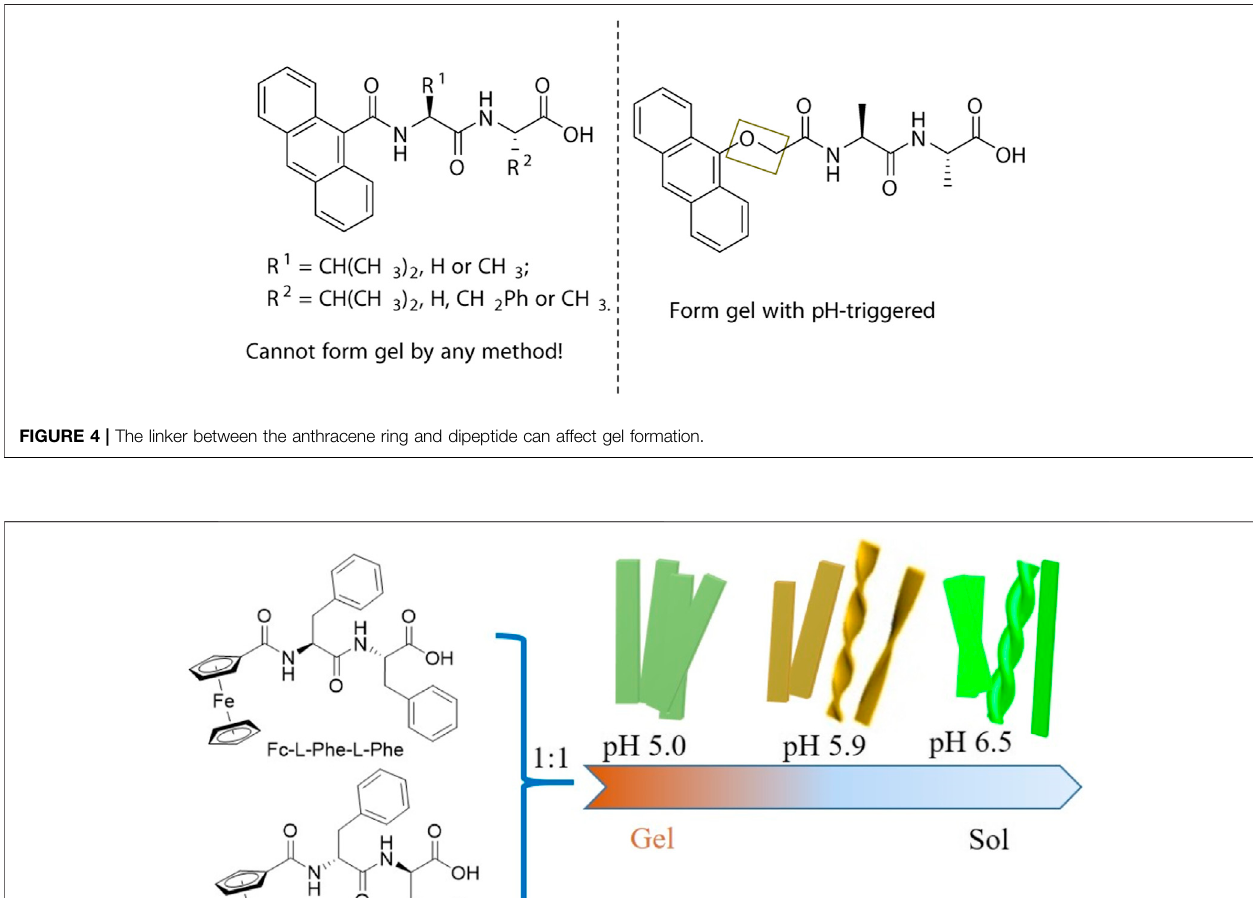
Frontiers in Chemistry |